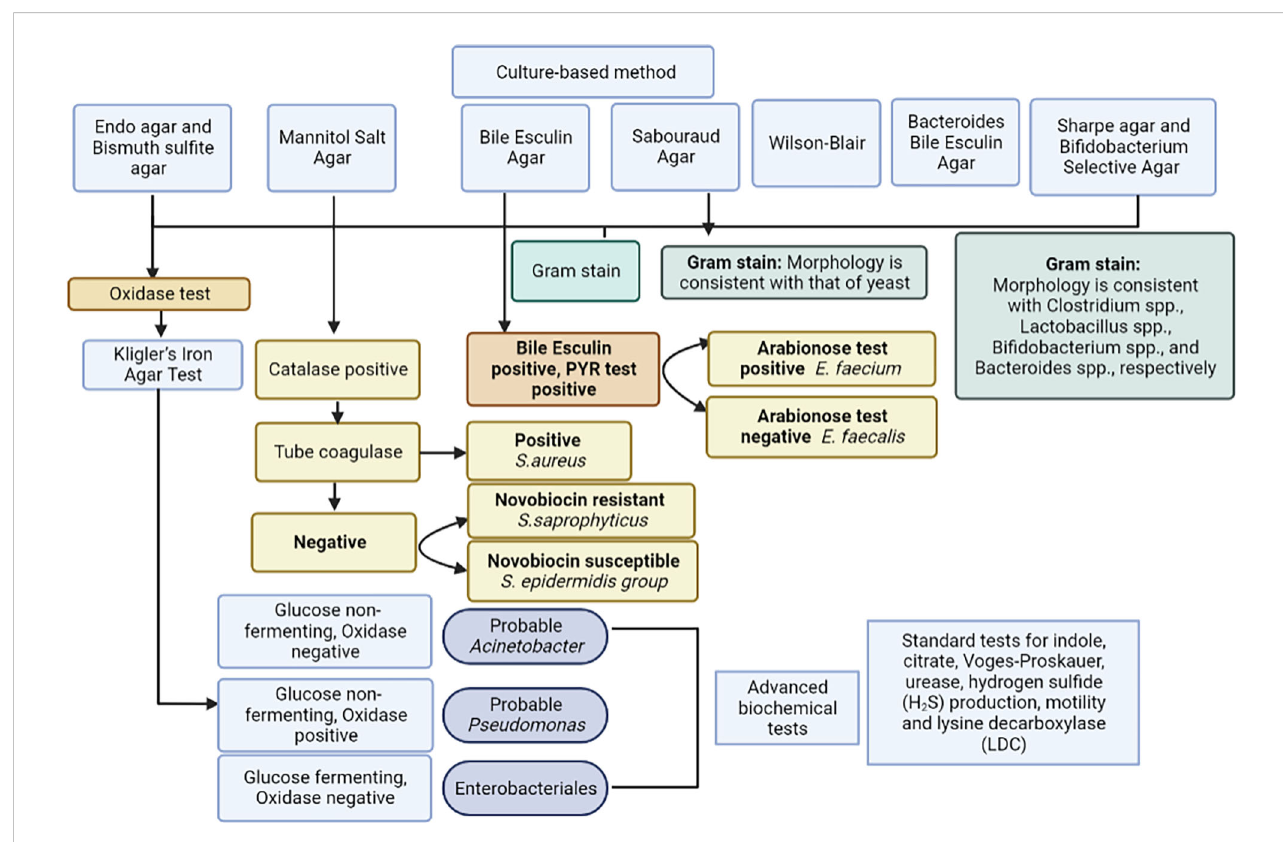
FIGURE 3 Methodology for bacterial identi fi cation.